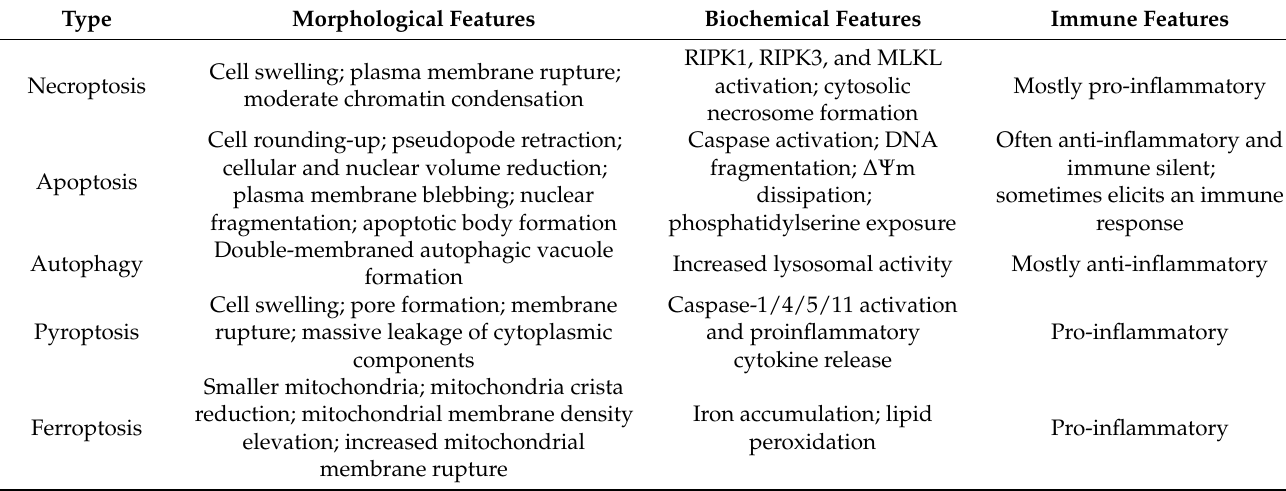
Table 1. The main features of various RCD